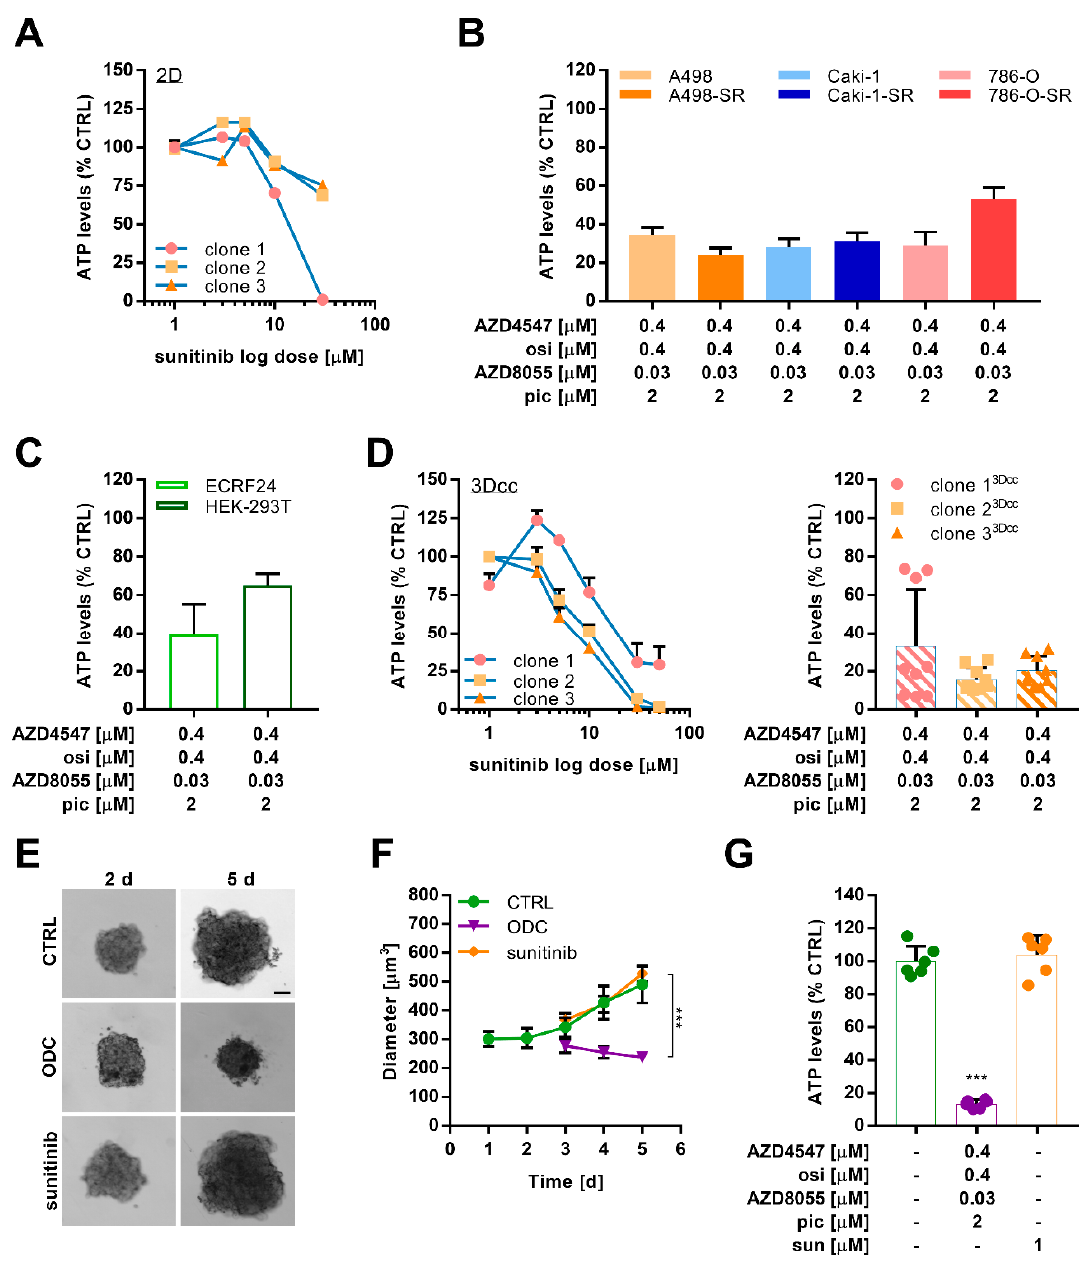
Figure 5. Tumor growth of Caki-1 and Caki-1-SR in vivo and ex vivo use for testing of optimized drug combinations. ( A ) Viability, measured as ATP levels, of sunitinib-resistant clones in a 2D monolayer (2D). ( B ) Response of sunitinib-naïve and -resistant ccRCC cells to an optimized multidrug combination treatment (ODC) containing AZD4547 (0.4 µM), osimertinib (osi, 0.4 µM), AZD8055 (0.03 µM), and pictilisib (pic, 2 µM). ( C) Effect of the ODC on non-cancerous cells ECRF24 and HEK-293T. ( D ) Viability, measured as ATP levels, of sunitinib-resistant clones in heterotypic 3D co-culture (3Dcc) with 10% endothelial cells (ECRF24) and 20% fibroblasts (NHDF α cells) in response to increasing doses to sunitinib (left graph) and the ODC (right graph). Error bars represent the SD. ( E ) Representative bright-field images of murine ex vivo spheroids taken on days 2 and 5 (2–5 d) after seeding. ODC treatment was applied onto the spheroids on 2 d and maintained for 72 h until 5 d.). Sunitinib was applied at a concentration of 1 µM. Scale bar = 100 µm. ( F ) Size measurements of the diameter of the murine ex vivo spheroids in time. Spheroids remained untreated (CTRL) or were treated with either the ODC or 1 µM sunitinib. Error bars represent the SD of six spheroids per condition ( n = 6). ( G ) Bar graphs representing the ATP levels (viability) as % compared to the CTRL in response to 72 h treatment with ODC and sunitinib. Error bars represent the SD of six spheroids per condition ( n = 6). Statistical significance was calculated based on n = 6 independent experiments by using a one-way ANOVA with unequal variances; *** p < 0.001.